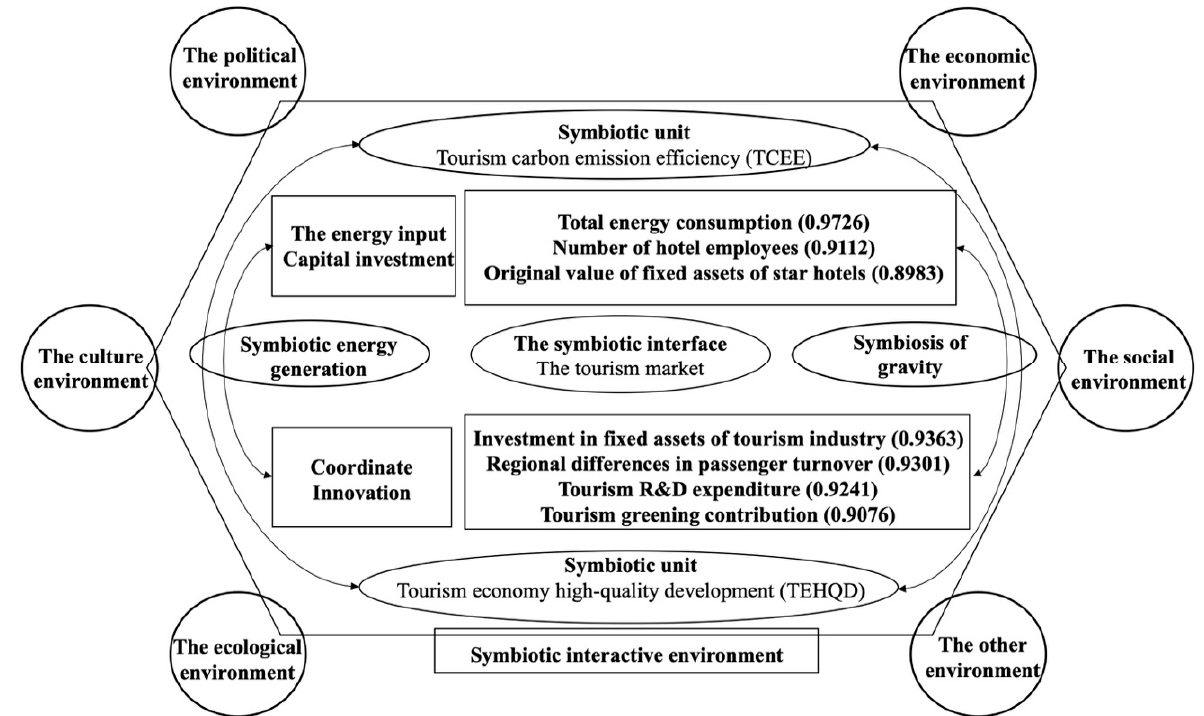
Figure 3. Interactive mechanism model of tourism’s carbon emission efficiency (TCEE) and the tourism economy’s high-quality development (TEHQD) in the Yellow River Basin.